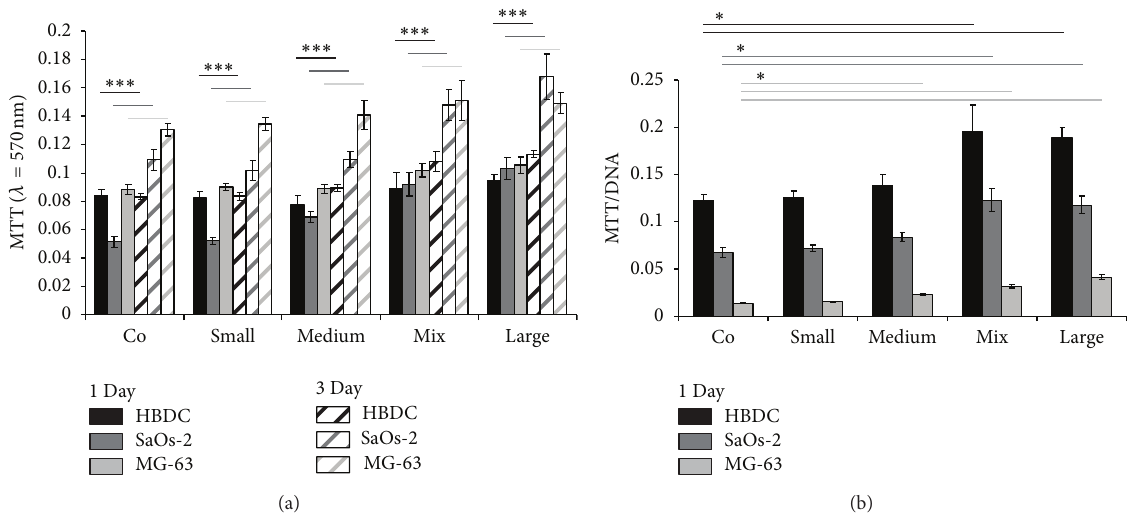
Figure 4: Viabilities. Three cell type MTT results per adherent cells: HBDC and osteosarcoma-derived cell lines SaOs-2 and MG-63. (a) The MTT assays were performed after 1 day (filled bars) and 3 days (striped bars) of culture. Significance levels were ∗∗∗ < 0.001 . (b) The MTT results referred to the DNA content after 1 day. Significance levels were ∗ < 0.05 .